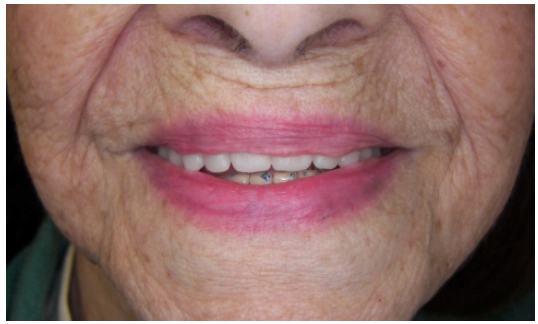
Figure 15. Patient’s photo in rest position with a light smile.